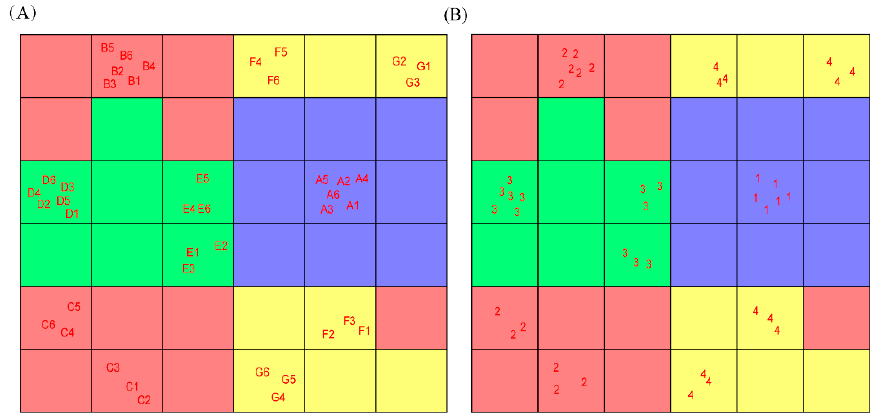
Figure 3. Kohonen map of associated-extraction efficiency of different cyclodextrins. ( A ) The distribution of different cyclodextrins and ( B ) the classes assigned to cyclodextrins (1: OAE, 2: traditional cyclodextrins, 3: water-soluble cyclodextrin derivatives, 4: ionic cyclodextrin derivatives).